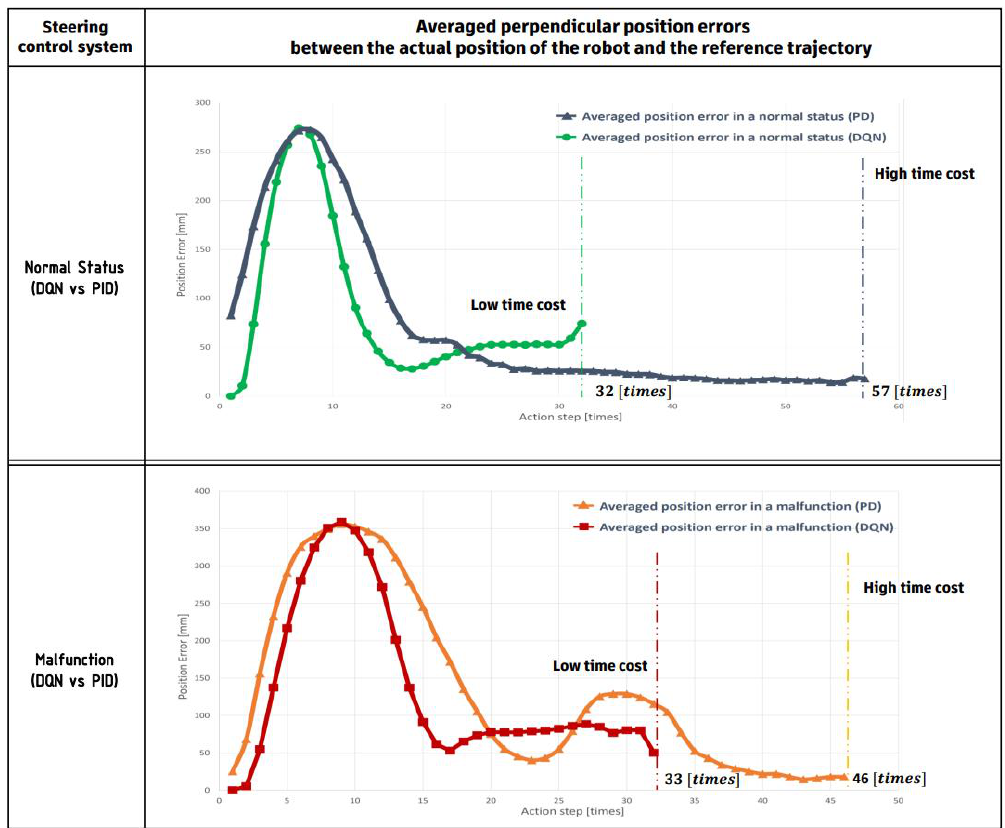
Figure 28. Time cost analysis of the two motion planning methods (PID and DQN) with respect to the average number of action steps required for the rover to reach the target point.